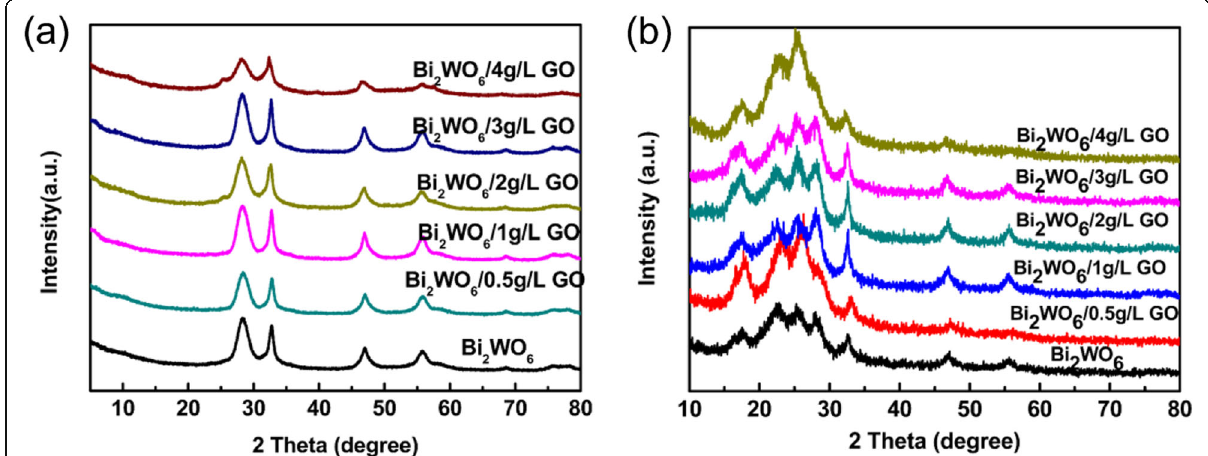
Fig. 3 XRD patterns of ( a ) Bi 2 WO 6 and Bi 2 WO 6 /GO particles, ( b ) Bi 2 WO 6 and Bi 2 WO 6 /GO deposited PET fabrics with different concentrations of